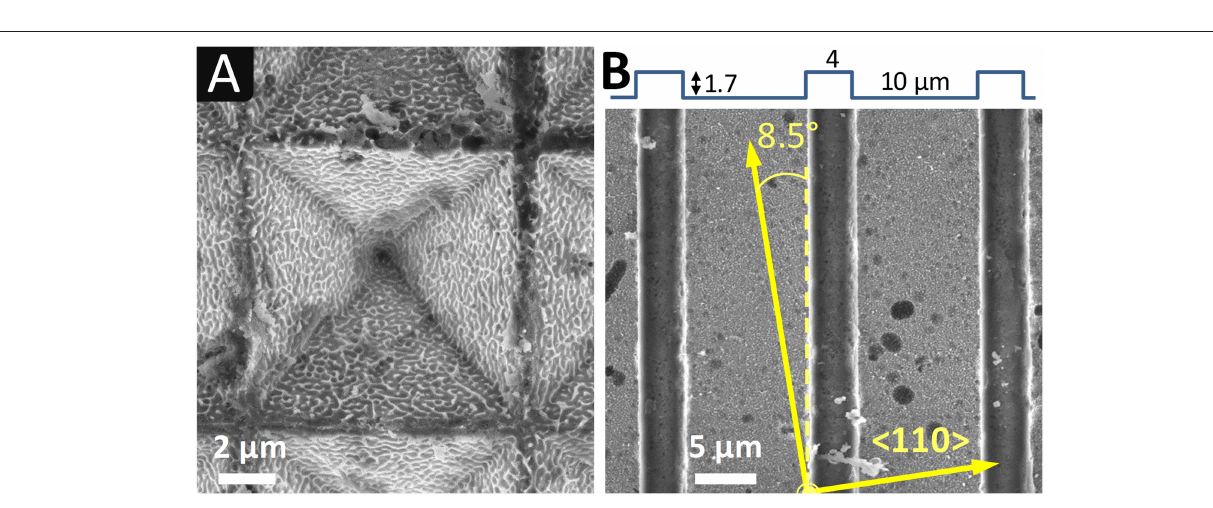
FIGURE 7 | SEM images of silicon surfaces after imprinting chemically (A) inverted pyramids and (B) U-shaped lines in HF-H 2 O 2 with coarse np-Au/Pt electrodes. Electrolyte: HF 5mol L − 1 - H 2 O 2 1mol L − 1 , with 2 vol.% EtOH. In (B) : line offset with respect to < 110 > directions, as determined by